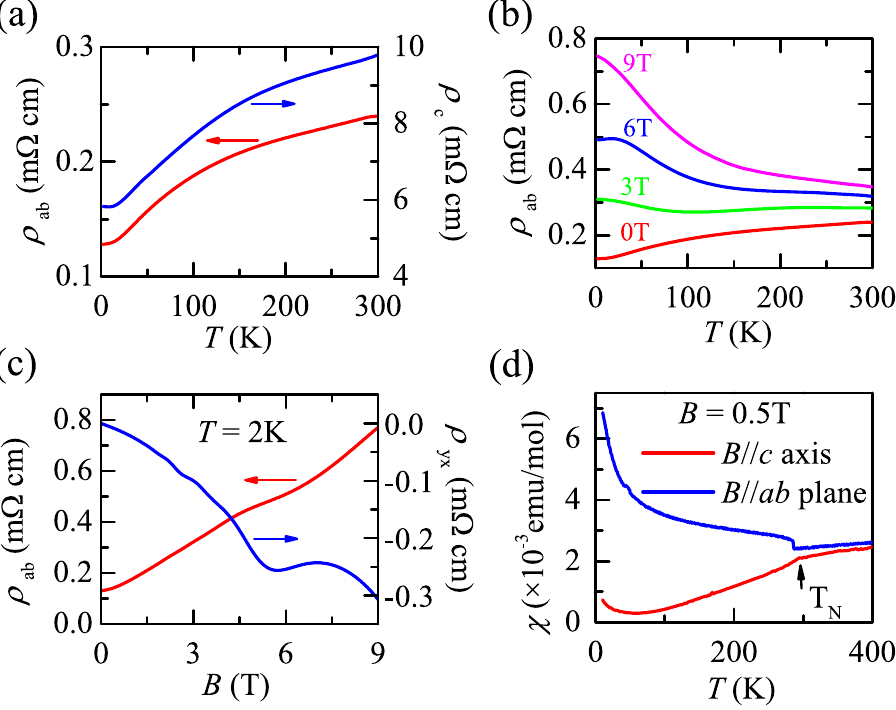
Figure 2. ( a ) Temperature dependence of the in-plane ( ρ ab ) and out-plane ( ρ c ) resistivity. ( b ) Temperature dependence of the ρ ab under various fields. ( c ) ρ ab and Hall resistivity ( ρ yx ) as a function of the out-of plane magnetic field at T = 2 K. ( d ) Temperature dependence of the magnetic susceptibility with field parallel and perpendicular to c axis for BaMnBi 2